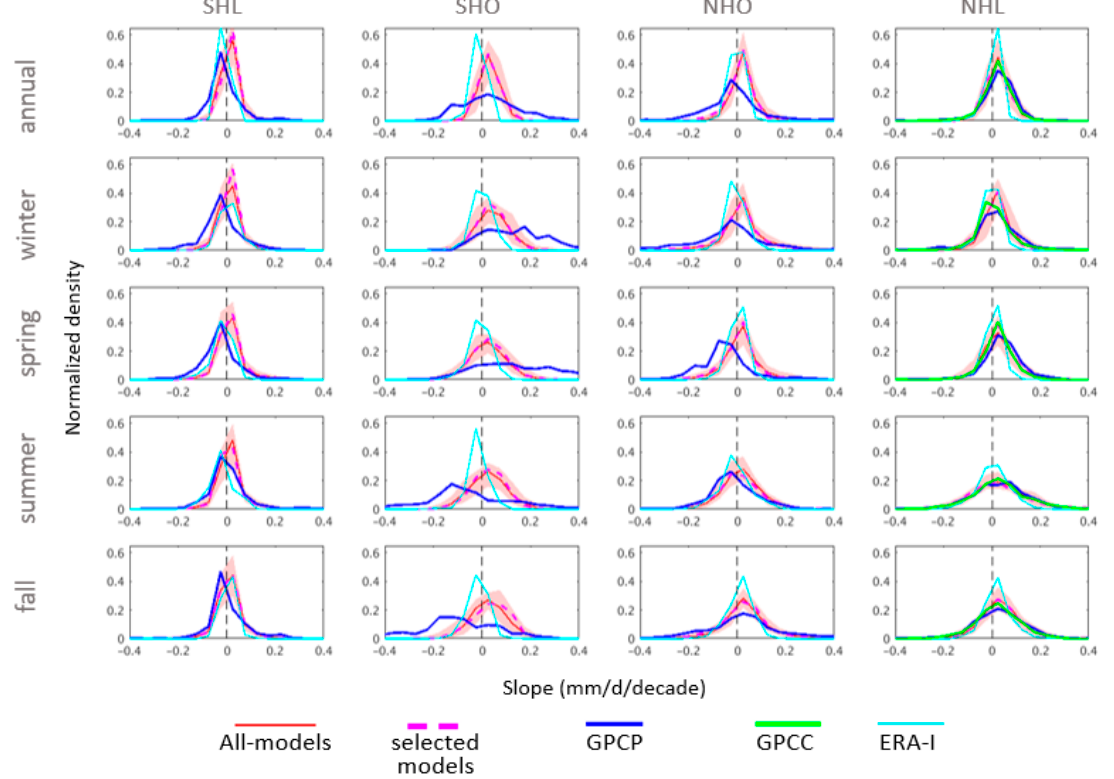
Figure 3. Normalized density plot of precipitation slopes calculated in each grid using 30 years of model (1976–2005), GPCP (1980–2009), GPCC (1980–2009), and ERA-I (1980–2009) data. Models 5–95% ensemble range is shown in pink shades and median as red line. Density plots are shown for four geographical regions. NH land includes land areas north of 55°N and Greenland.